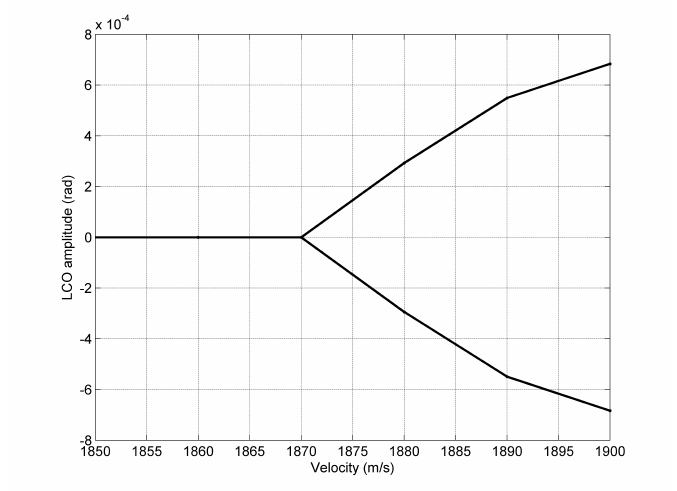
Figure 11. Bifurcation plot for transient heat load.